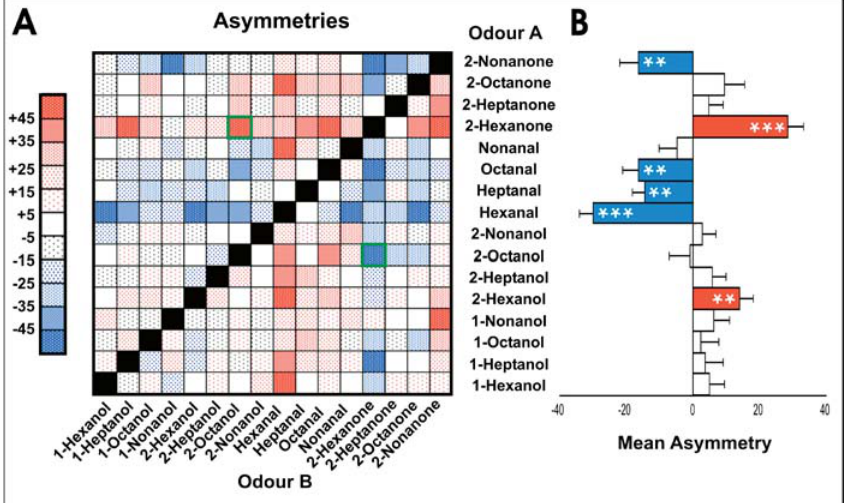
Figure 5. Asymmetric Generalisation between Odours (A) The asymmetry matrix depicts asymmetric cross-generalisation between odours. For each odour pair (A and B), the difference (percentage) between generalisation from A to B and generalisation from B to A was calculated. Such differences were ranked in 10% categories varying from blue ( (cid:1) 55%) to red (55%). Blue shades indicate that cross-generalisation was biased towards odour A (i.e., conditioning to A resulted in lower generalisation to B, while conditioning to B resulted in higher generalisation to A); red shades indicate that cross-generalisation was biased towards odour B (i.e., conditioning to A resulted in higher generalisation to B, while conditioning to B resulted in lower generalisation to A). For this reason, each odour pair (A and B) appears twice in the matrix, once in the upper-left of the black diagonal line, and once in the lower-right of the black diagonal line, with opposite values. See, for example, the two cells outlined in green for the pair 2-hexanone/2-octanol. (B) Mean generalisation induced or diminished by each odour A in (A). Each bar represents the mean asymmetry of the respective horizontal line in the asymmetry matrix. Red bars show that an odour induced more generalisation than it received, while blue bars show the opposite. Significant generalisation asymmetries were found in six out of 16 cases (**, p , 0.01; ***, p , 0.001). DOI: